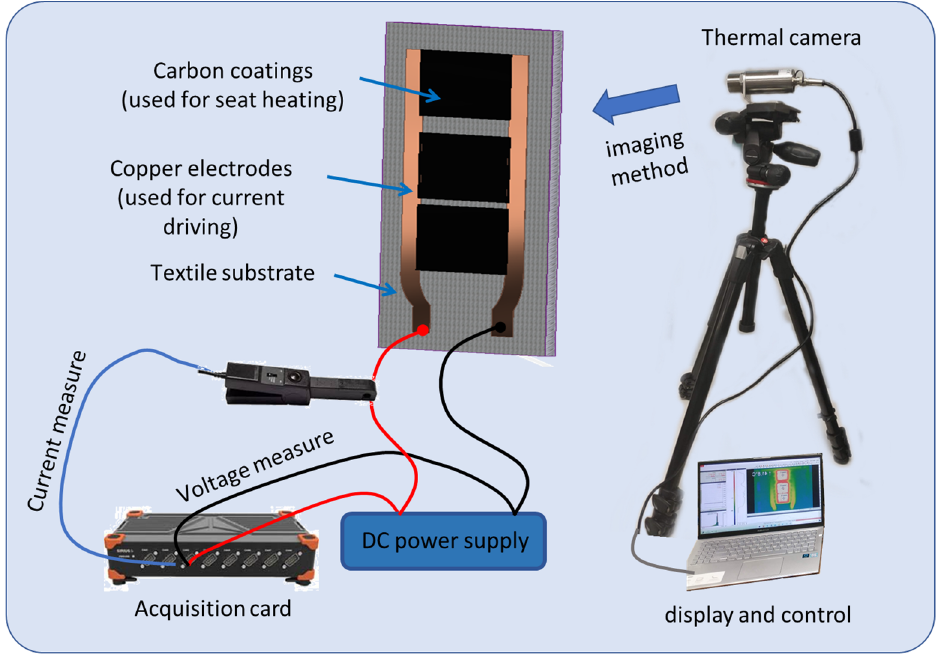
Figure 12. Schematic illustration of the measuring bench used for the thermal characterization of a heated